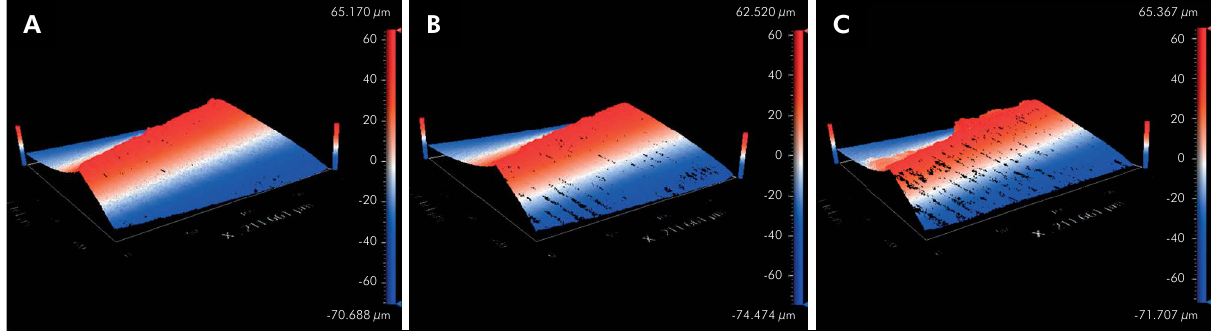
Figure 2. Three-dimensional high-resolution optical profilometry images of the cutting blade of a WaveOne instrument, before use (a) and after the first (b) and second (c)